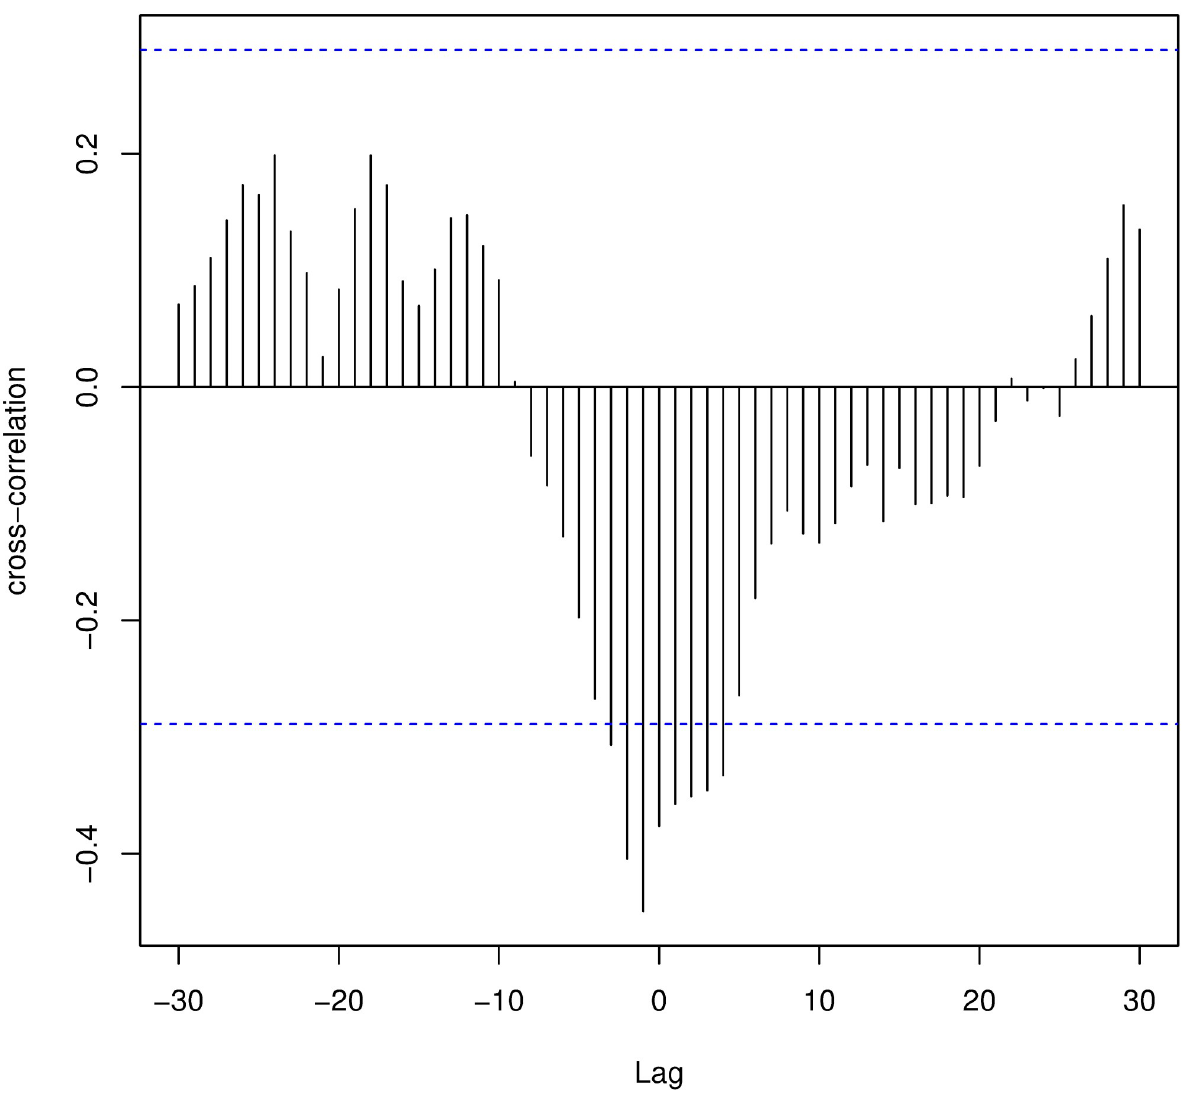
Fig 9. Cross-correlation between mobility data and disease spread. Representation of the cross-correlation between R ( t ) is the cars’ flow obtained by DETRAN-CE. We observe that, the correlation is maximum (in module) for lag = − 1.